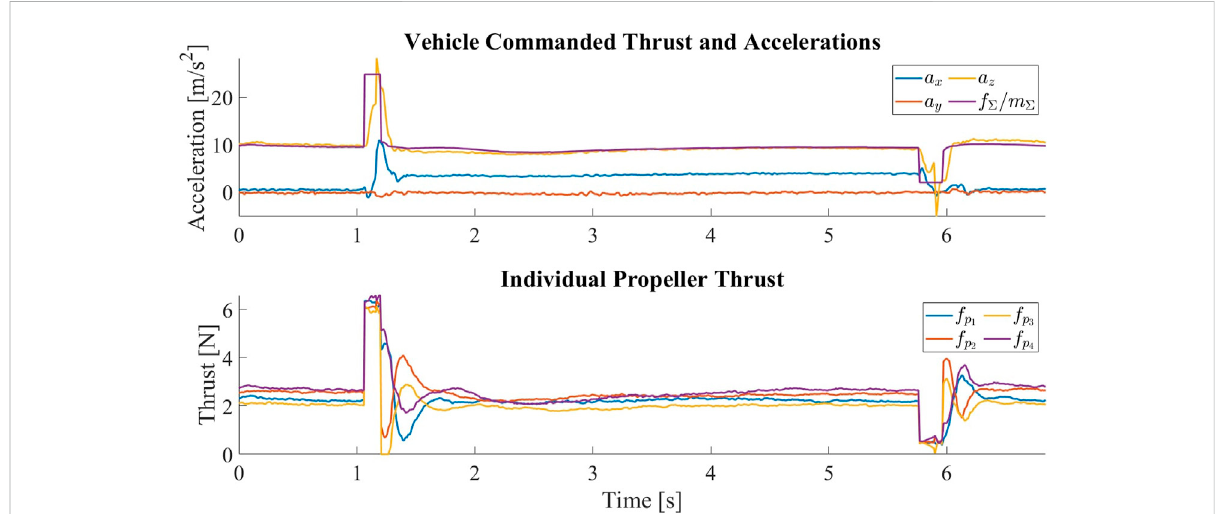
FIGURE 13 The vehicle commanded thrust normalized by the vehicle mass and the measured accelerations in the central body frame C for one tilt and untilt cycle. At around t = 1s, the vehicle is commanded to tilt by producing a sudden high thrust. The surge in thrust is followed by a surge in the acceleration along z C , which is then followed by an increase in the acceleration along x C , meaning that the thrust axes of the propellers have been tilted forward. The negative x C acceleration between transitions indicates the change of the vehicle ’ s pitch angle such that the propellers are pointing upward to keep the vehicle at hover. At around t = 4.5s, the vehicle is commanded to untilt by producing a sudden low thrust. The drop in thrustisfollowedbyadropintheaccelerationalong z C ,whichisthenfollowedbyadropinthemagnitudeofaccelerationalong x C ,meaningthatthe thrust axes of the propellers have been restored. Despite the change in the mapping matrix, we can see that the individual propeller thrusts are very close once the vehicle has stabilized after the transition.